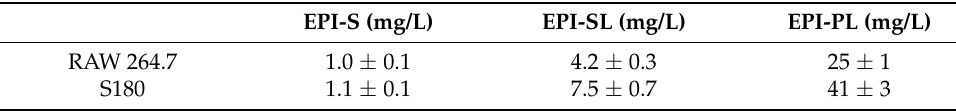
Table 2. The IC 50 value of EPI-S, EPI-SL, and EPI-PL ( n =